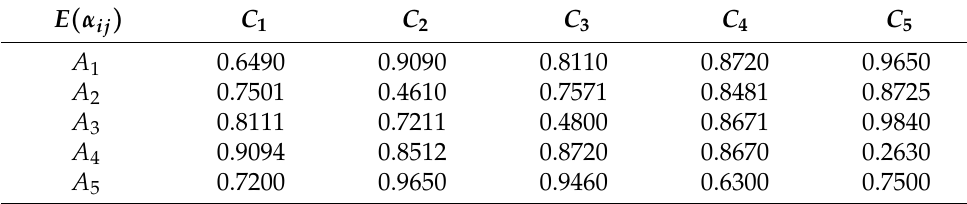
Table 2. Entropy of α ij .